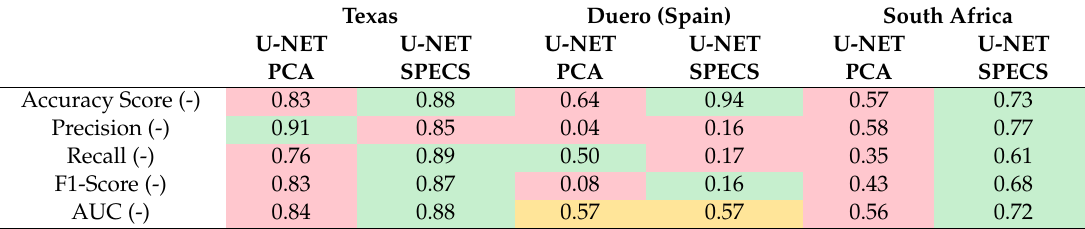
Table 6. Pixel-based metrics of classification accuracy for the CPS class, including the accuracy score, precision, recall, f1-score, and the area under the curve (AUC). For each study area, the results of the two U-NET implementations are